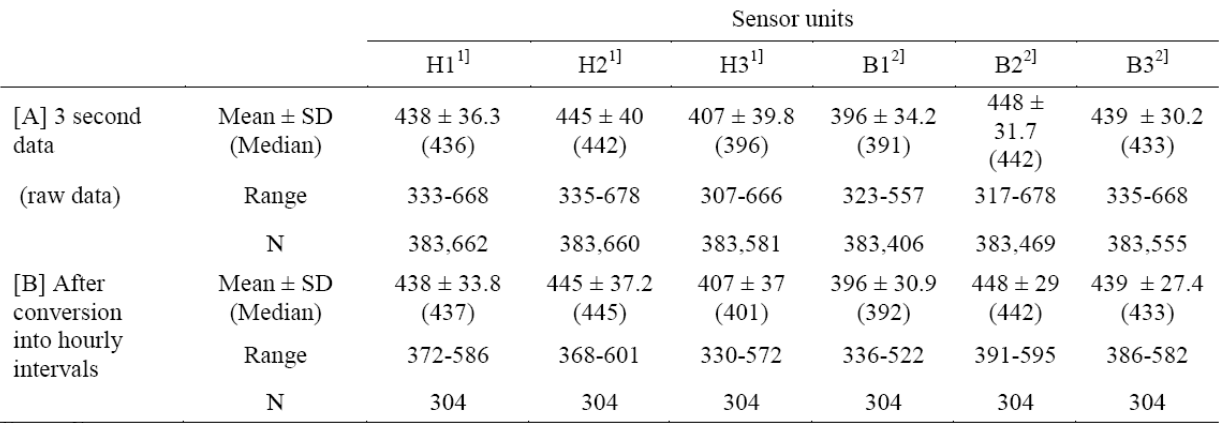
concentration data measured using two different 2